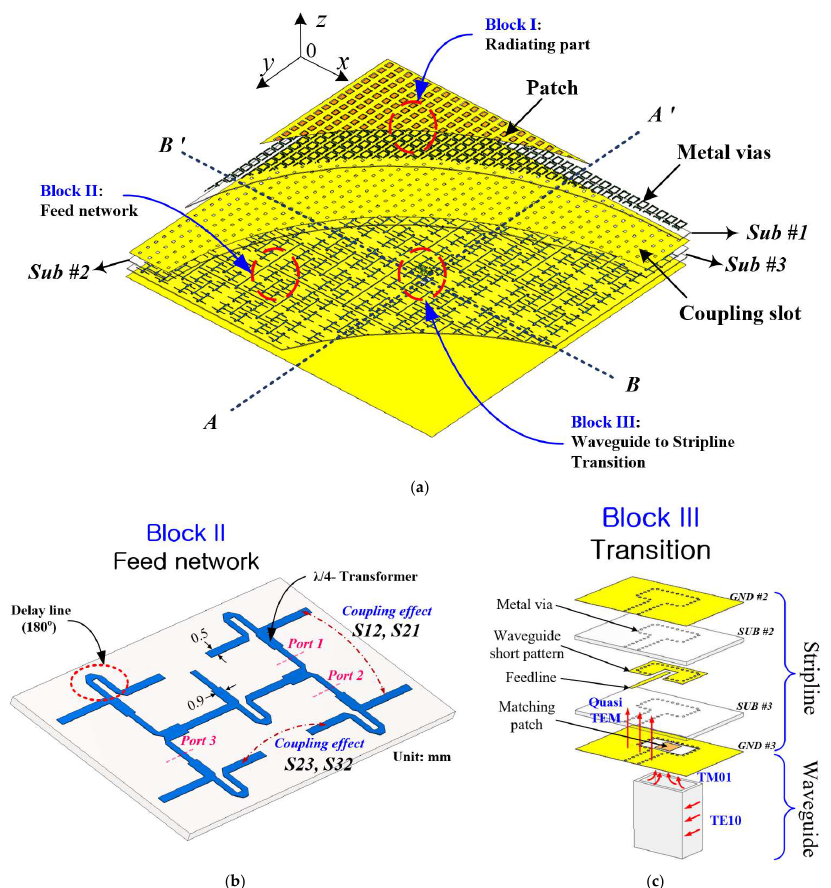
Figure 7. ( a ) Configuration of the proposed array antenna. ( b ) Detailed 3-D view of the corporate-feed network. ( c ) De- tailed 3-D view of the waveguide-to-stripline